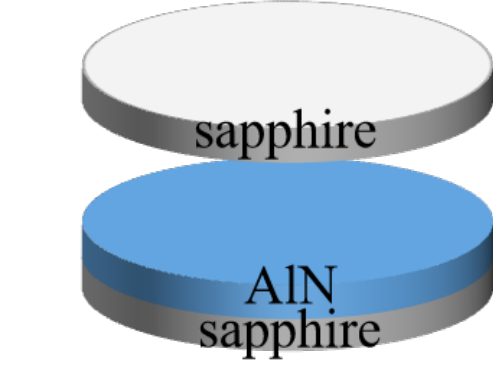
Figure 1. Schematic diagram of face-to-face setup.